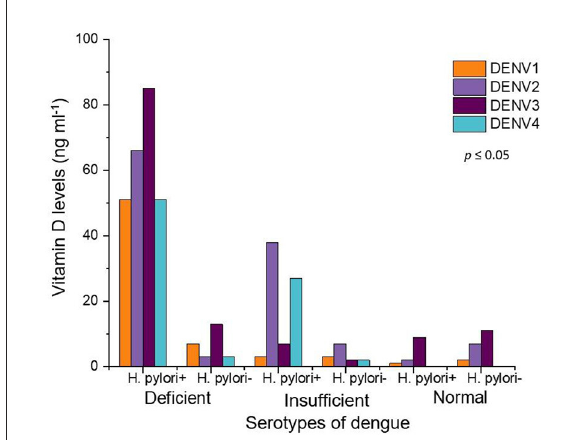
FIGURE2 “Deficient”, “insufficient” and “normal” levels of vitamin D in dengue fever ( H. pylori + and H. pylori -) patients without warning signs.